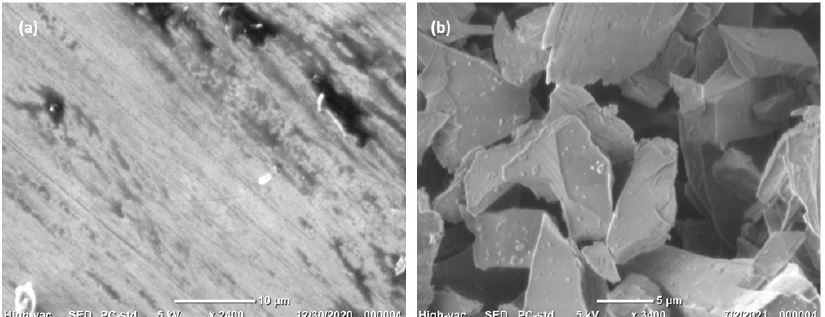
Figure 1: SEM of (a) Base metal ‘A’ and (b) Si 3 N 4 particulates.